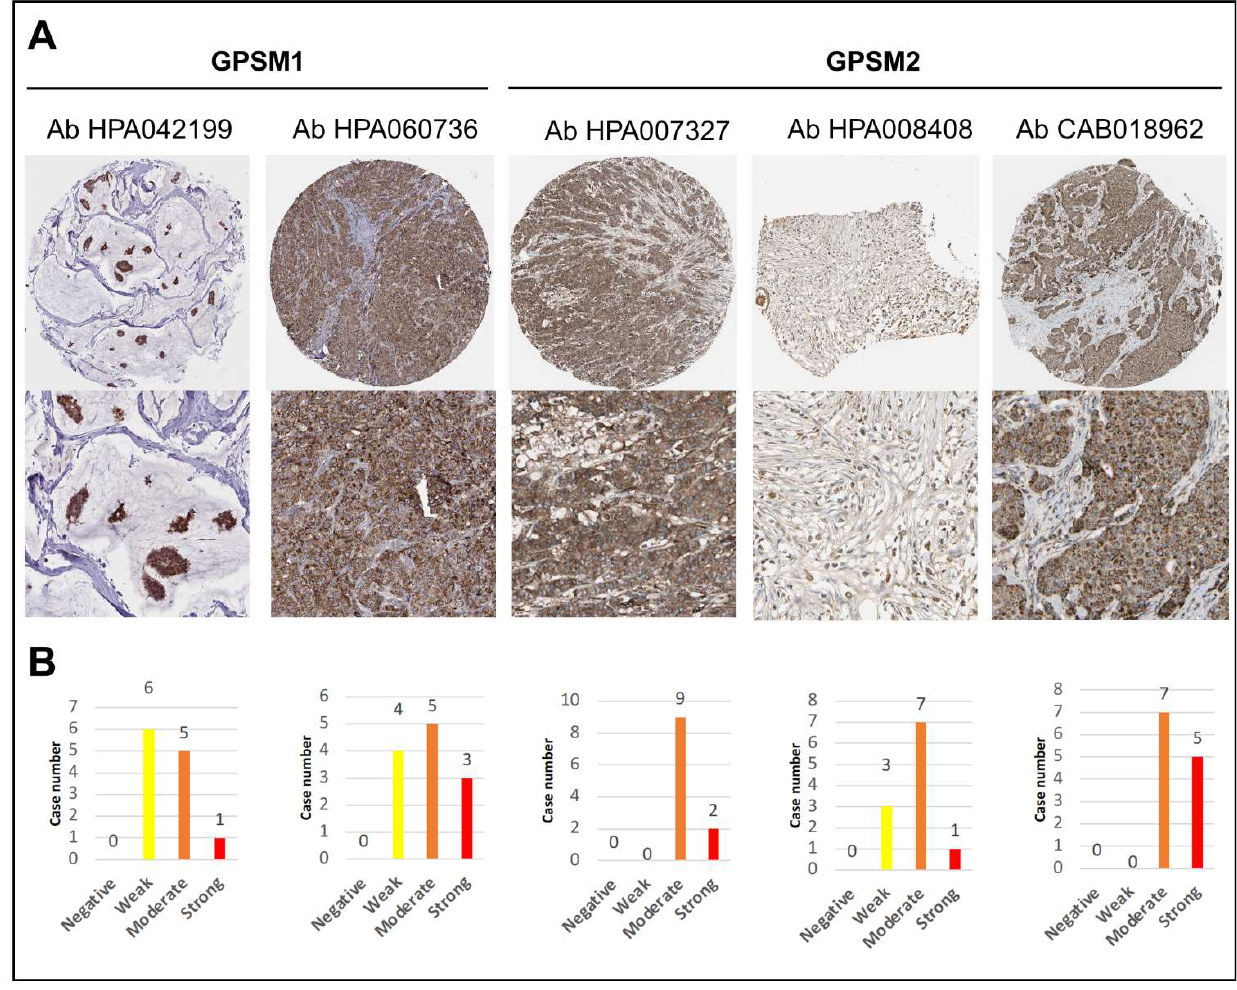
Figure 4. Protein expression profiles of GPSMs in breast cancer samples (Human Protein Atlas). ( A ) Representative strongly stained IHC images and ( B ) bar charts showing IHC staining intensity of GPSM1 and GPSM2 in breast cancer tissues. Corresponding data of GPSM3 and GPSM4 were not found. Ab, antibody; IHC, immunohistochemistry.